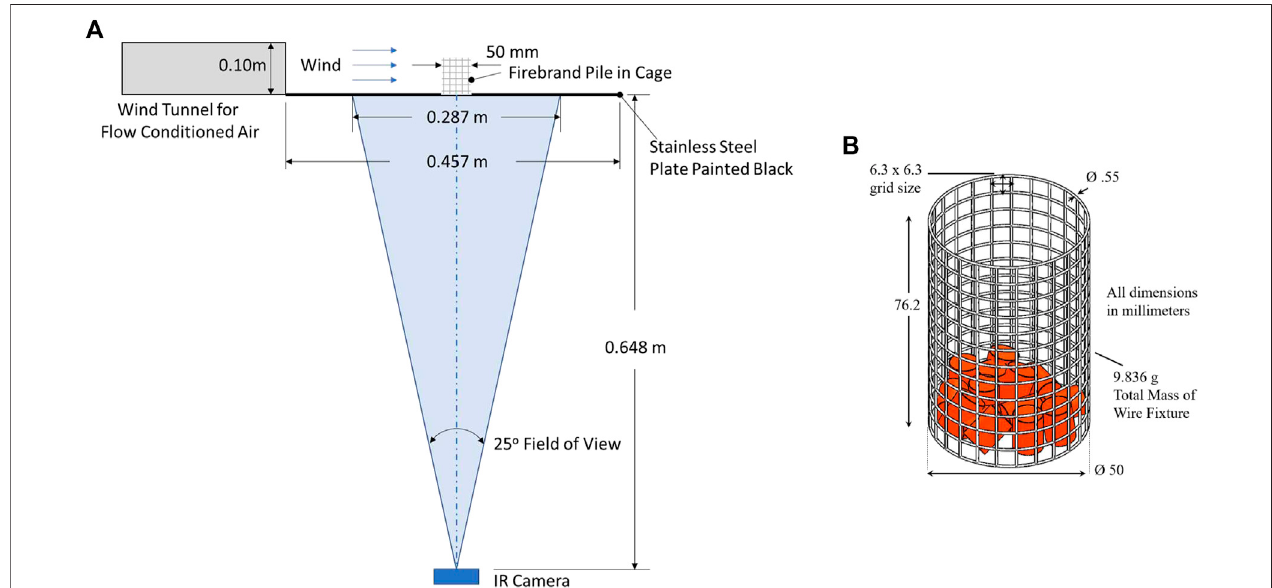
FIGURE 1 | Overview of test details including (A) test setup and (B) metal mesh cage used to contain fi rebrand piles.